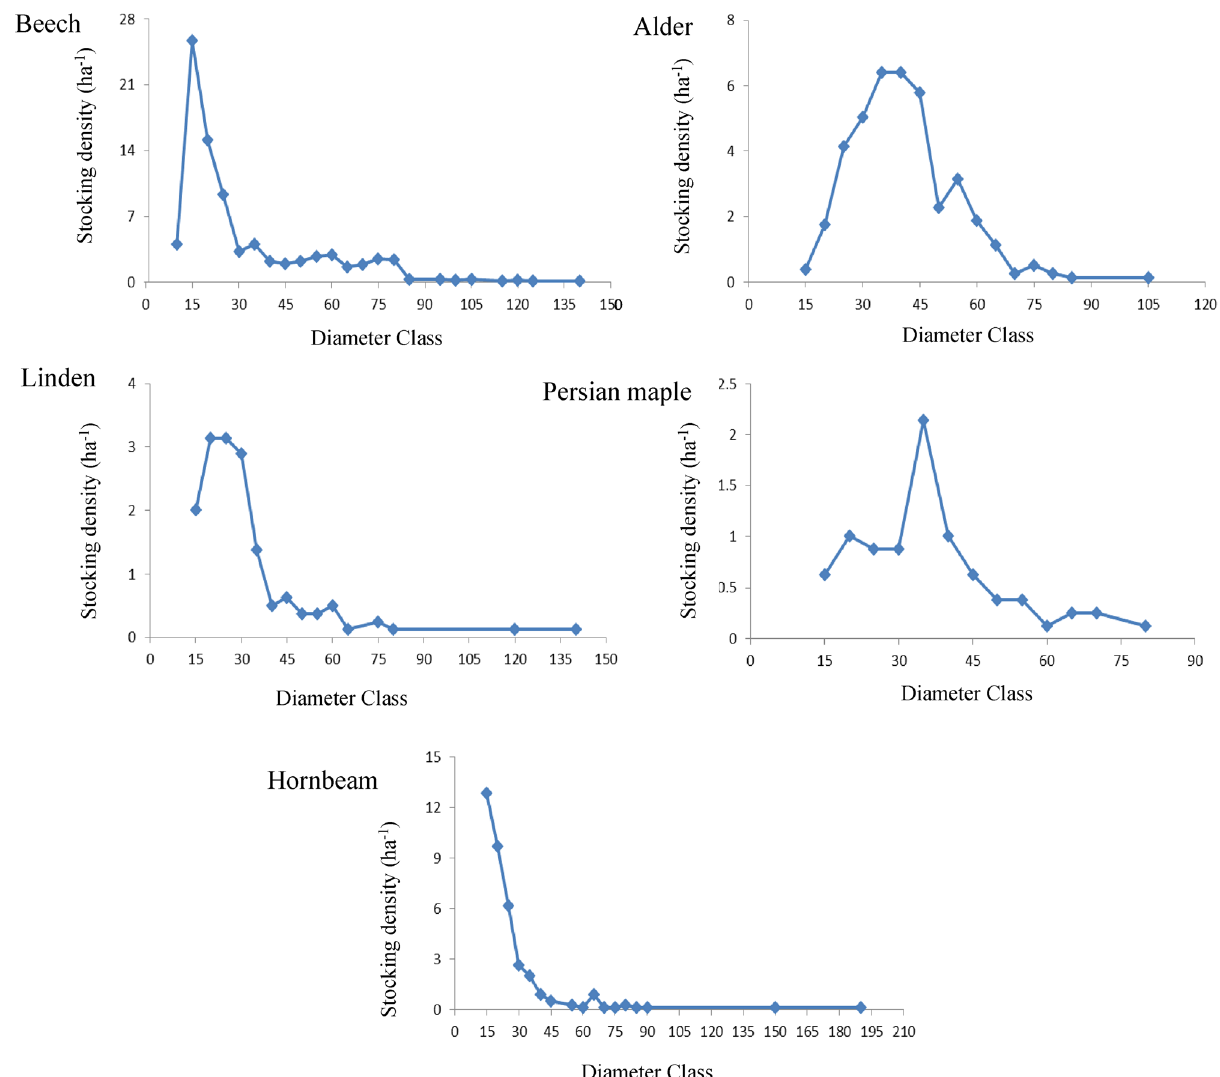
Figure 4. Stocking density of trees by diameter class, for beech ( Fagus orientalis ), alder ( Alnus subcordata ), linden ( Tilia platyphyllos ), Persian maple ( Acer velutinum ) and hornbeam ( Carpinus betulus ), using dbh-classes of 5-cm